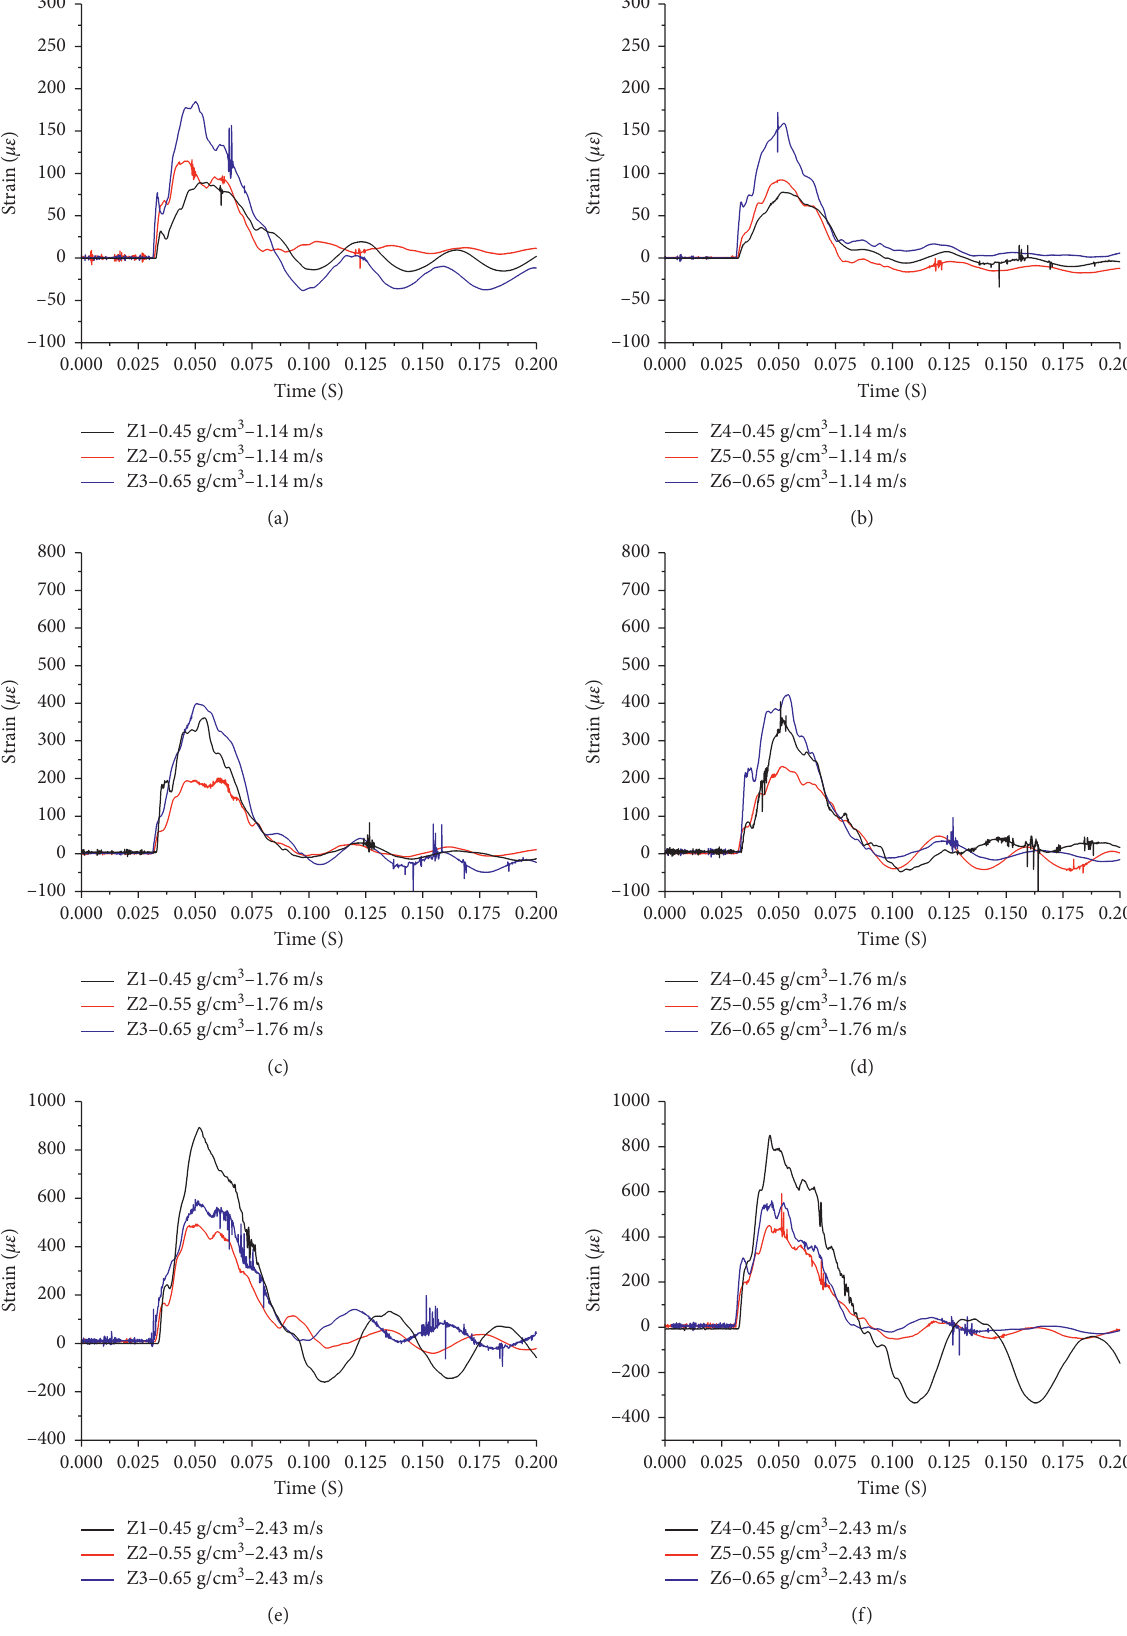
Figure 13: Time history curves of the strain of No. 5